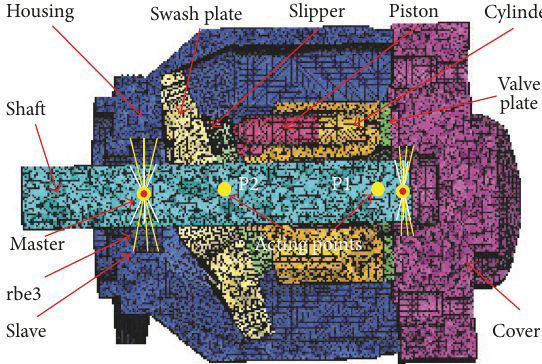
plate (P2) as can also be seen in Figure 8. The interpolation spider elements were used to connect the acting points with the surrounding elements. 𝐹 𝑍1 , 𝑀 𝑋1 , and 𝑀 𝑌1 were attached to P1, and 𝐹 𝑌2 , 𝐹 𝑍2 , 𝑀 𝑋2 , and 𝑀 𝑌2 were attached to